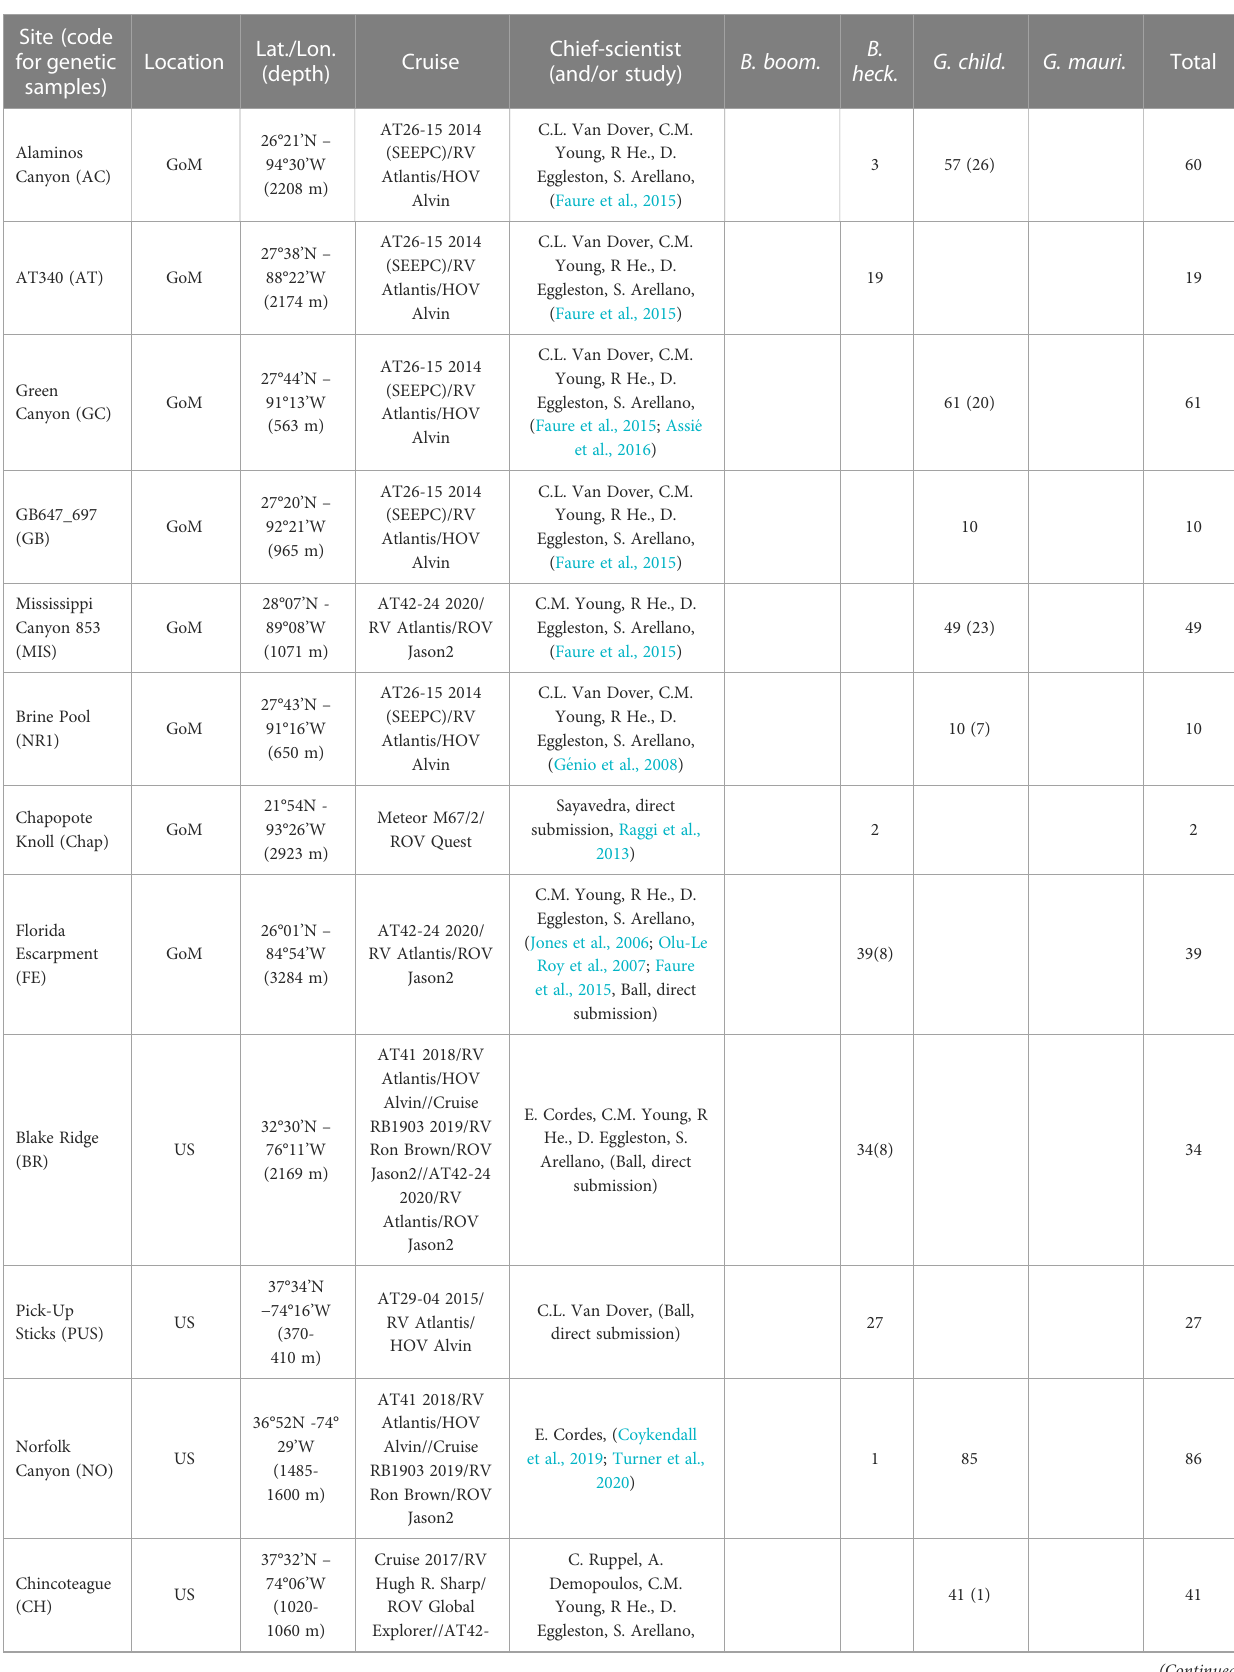
TABLE 1 Number and locations of all sequences used in analyses. The total numbers per site are reported as well as, within brackets, the number of newly sequenced individuals among this total number. Site (code for genetic